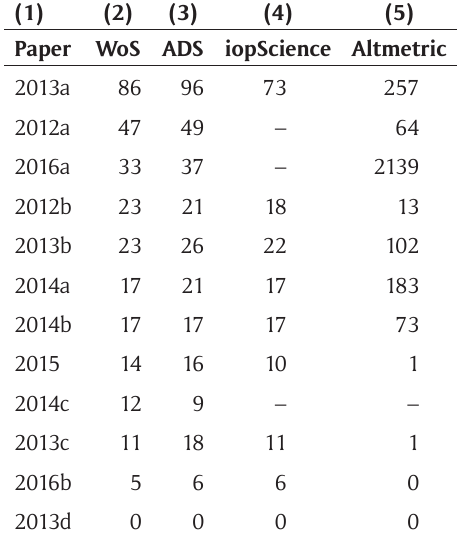
Table 4: Comparison of citation statistics for Planet Hunters